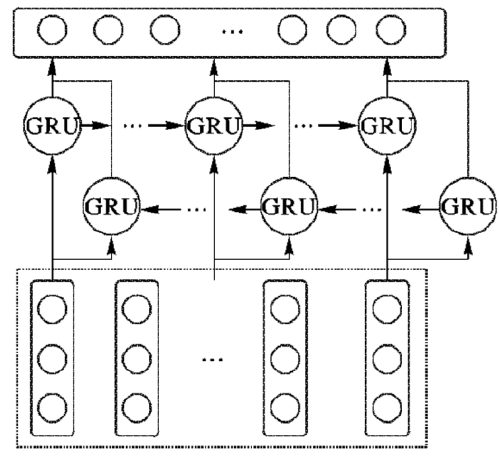
Figure 2. BiGRU-Attention model